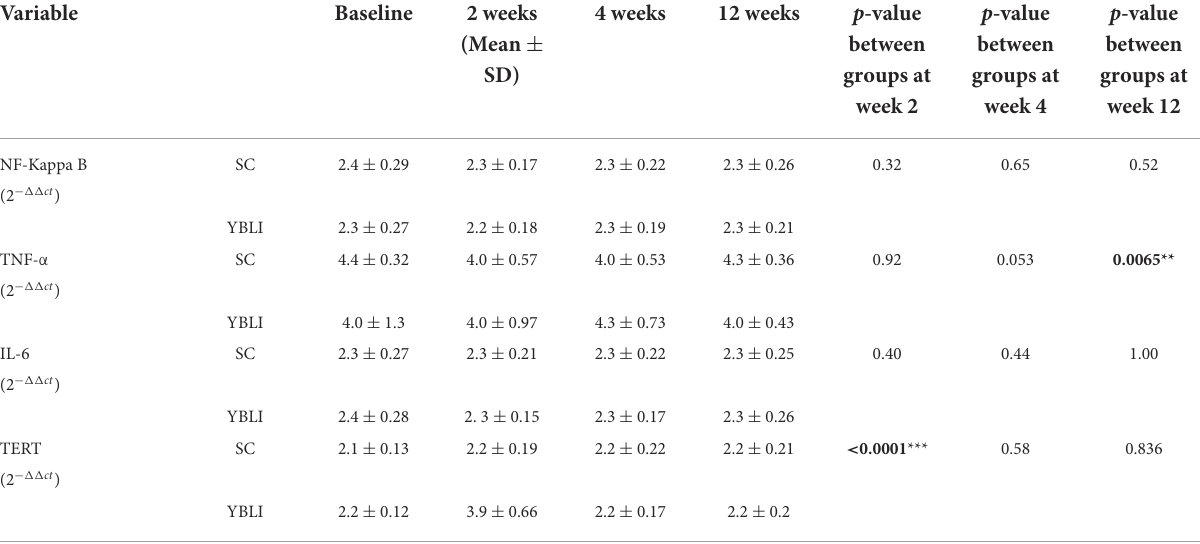
TABLE 5 Relative fold change (2 − 11 ct values) of oxidative stress (NF-Kappa B) inflammation (TNF- α , IL-6) and aging (TERT) gene between the SC ( n = 36) and YBLI ( n = 36) groups, between groups comparison. Variable Baseline